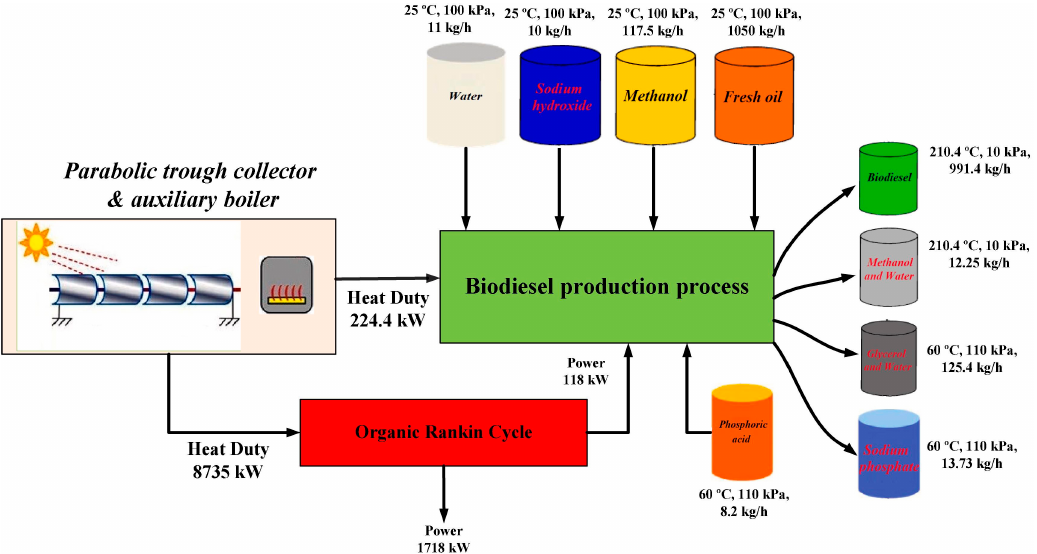
Figure 11. Biodiesel production using parabolic trough solar collectors [159].